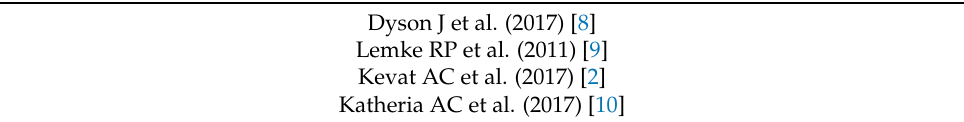
Table 3. Excluded